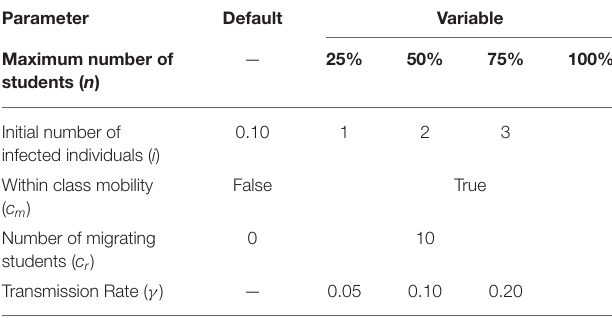
TABLE 1 | The parameter values used in the agent-based model.